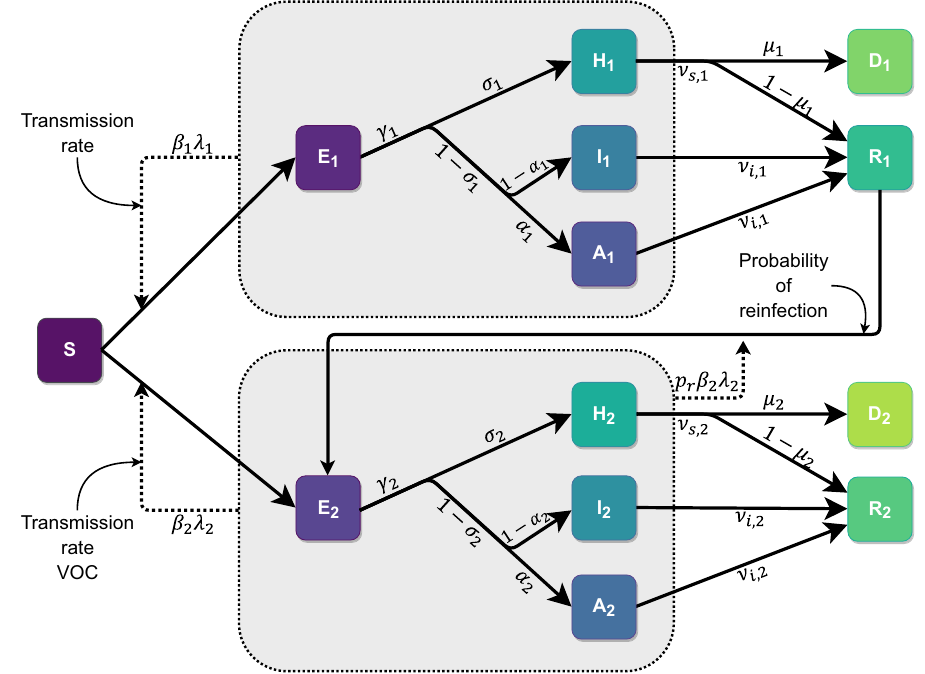
Fig. 1 Diagram of the extended deterministic compartmental model (SEAIHRD). The model compartments and the respective connections between them are summarized in this diagram, and they are named as S: Susceptible, E: Exposed (pre-symptomatic), H: Hospitalized (severe infected individuals), I: Infected (symptomatic individuals, not hospitalized), A: Asymptomatic. D: Deceased, R: Recovered. Compartments are subdivided into three age categories, not represented here for simplicity. Compartments with subindex 1 represent the wild-type variant, subindex 2 refers to the VOC P.1. Continuous lines represent fl ux between each compartment; dashed lines, infection pathways. Small arrows indicate force of reinfection and transmissibility. λ = force of infection. β = relative transmission rate. p r = relative force of reinfection. γ = average time between being infectious and presenting symptoms. σ = proportion of severe cases that require hospitalization. α = proportion of asymptomatic cases. ν s = average time between being infectious and recovering for severe cases. ν i = average time between being infectious and recovering for mild/asymptomatic cases. μ = in-hospital mortality